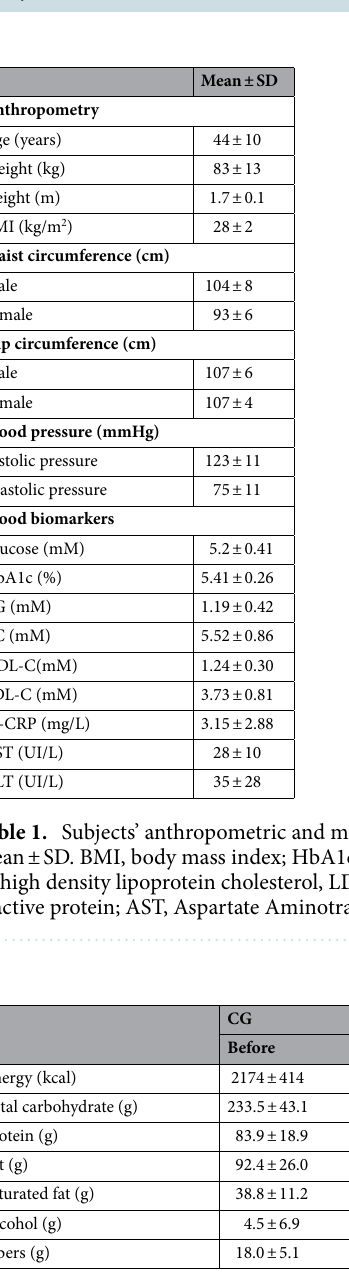
Table 2. Daily dietary intake throughout the study (n = 15). Data are expressed as mean ± SD. CG, chitin glucan; CTL, control. A mixed linear model with treatment, time, period and sequence as fixed variables and subjects as random effect has been performed. None of the p values associated to time is significant.